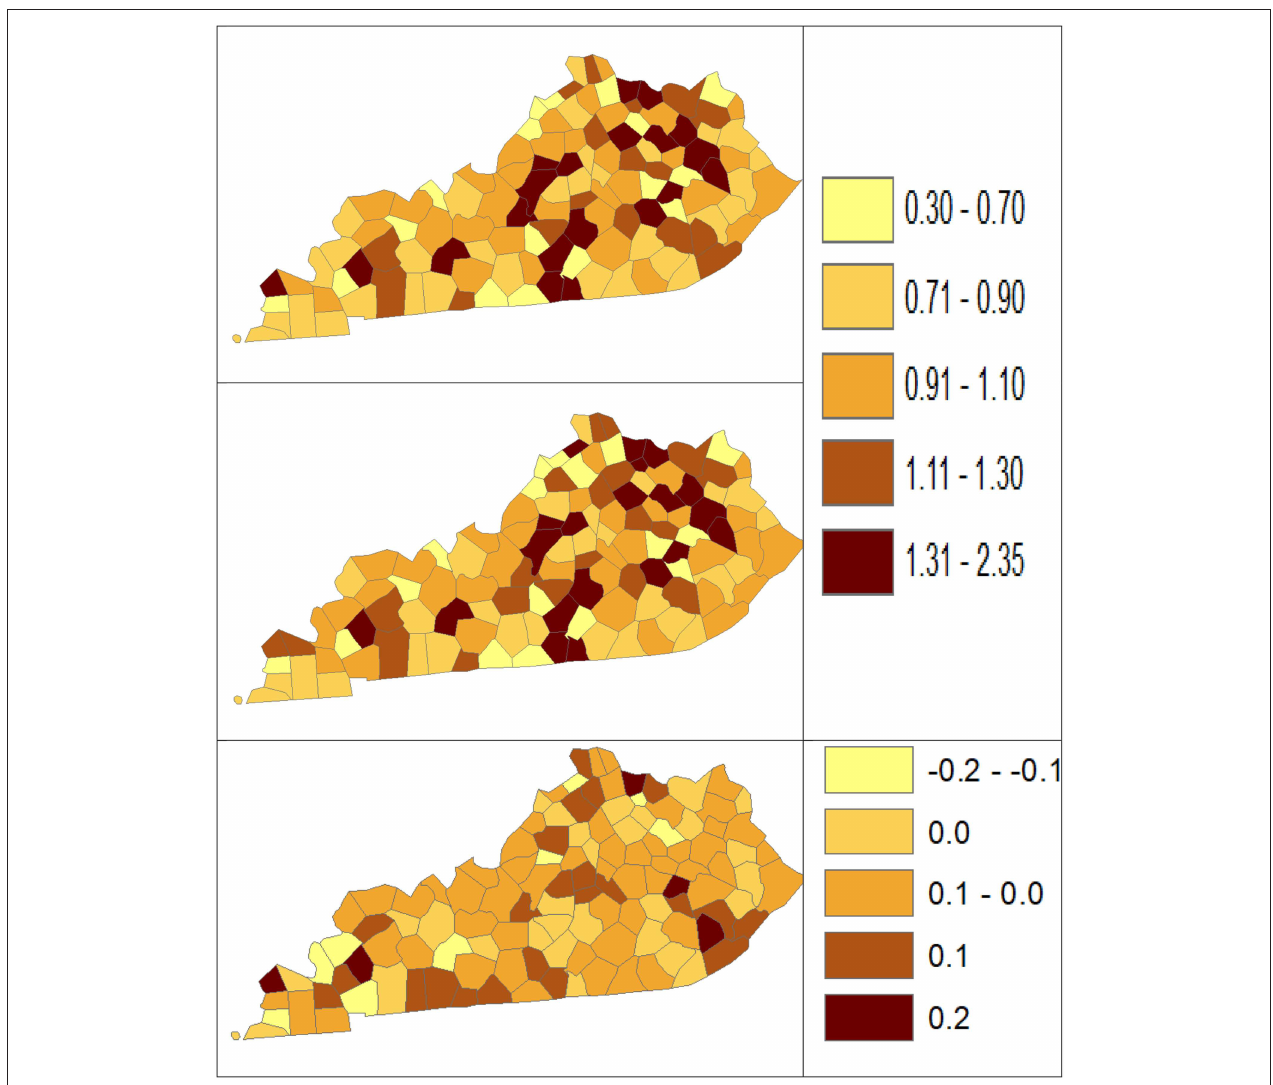
FIGURE 4 | Rate Ratio estimated from statistical methods (Direct top vs. BCM middle) and their difference (bottom) using 2006–2010 oral cancer incidence